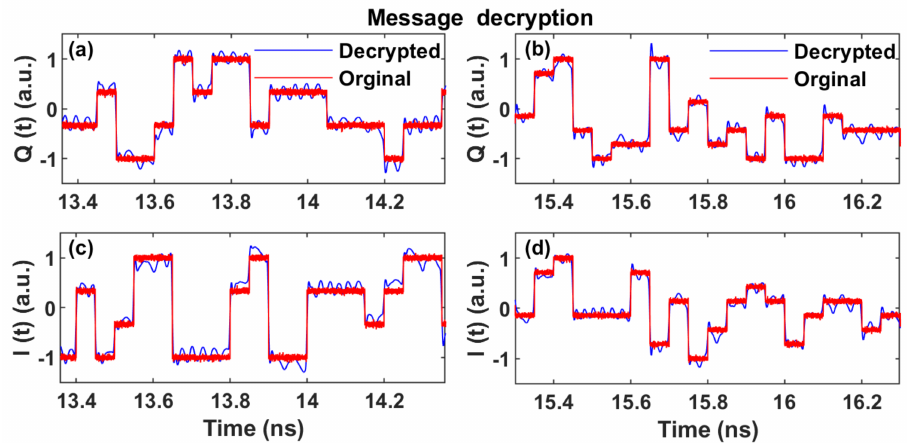
Figure 4. ( a , c ) Message 1 and ( b , d ) Message 2 of the original, decrypted ( a , b ) Q (t) signals and the original, decrypted ( c , d ) I (t)